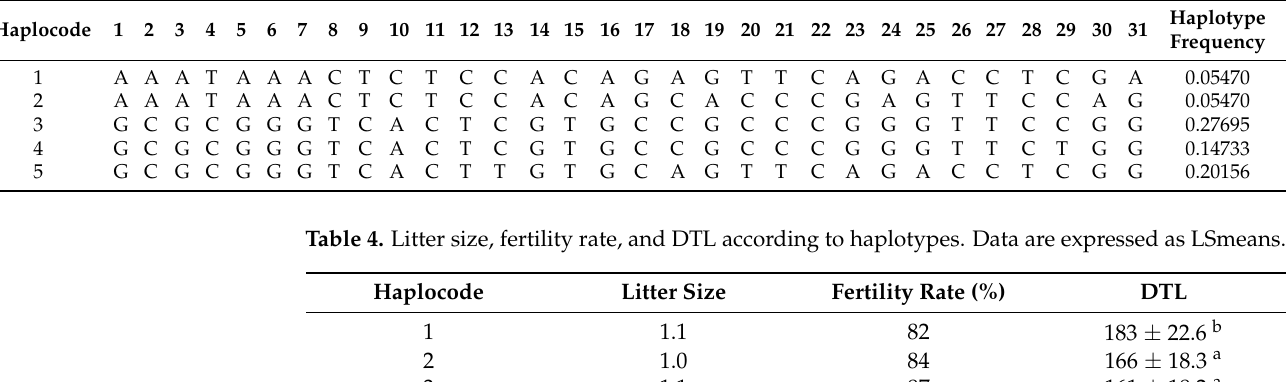
Table 3. Haplotypes and their frequency in the enrolled ewes.